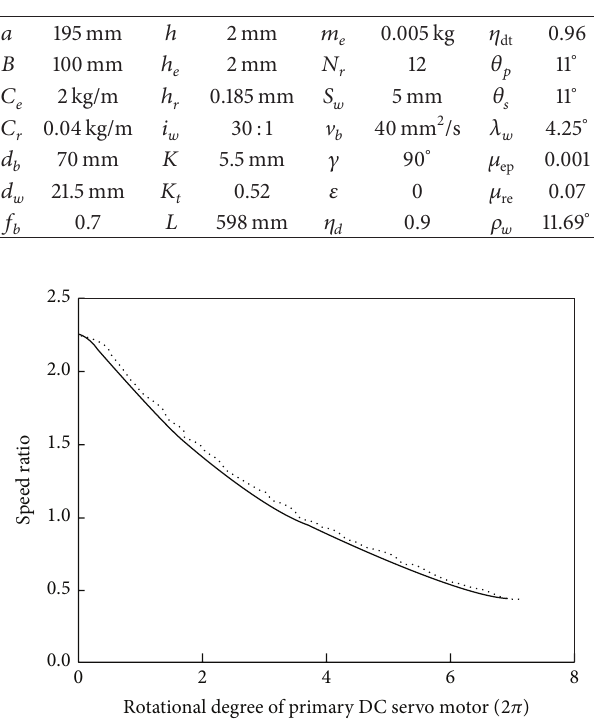
Table 1: Parameters of analytical model and prototype of DBVCVT.